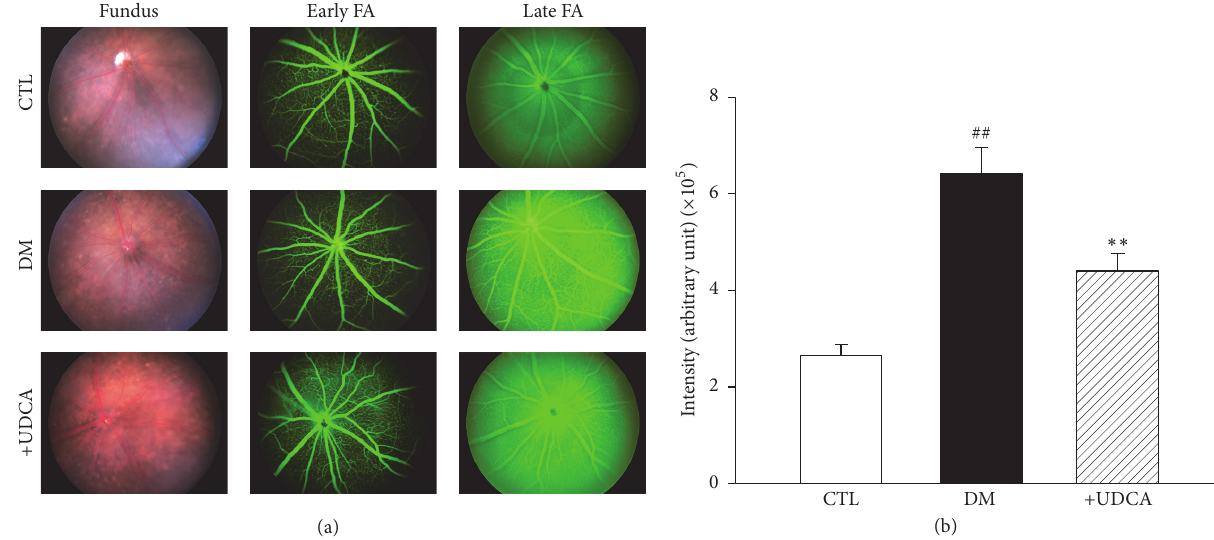
Figure 1: Effect of UDCA on vascular integrity in STZ-induced diabetic mice. (a) Representative fundus images and fluorescein angiography (FA) of early- and late-phase DR in control nontreated and UDCA-treated diabetic mice. (b) Fluorescein leakage was increased in diabetic mice ( 𝑛 = 8 ) at the late phase of fluorescein angiography, compared to control mice ( 𝑛 = 8 ), and decreased in diabetic mice treated with 100mg/kg UDCA ( 𝑛 = 11 ). Fluorescein angiographs of the early phase were obtained 3 min after fluorescein injection (early FA), while those of the late phase (late FA) were taken at 15min. ## 𝑃 < 0.001 versus control mice, ∗∗ 𝑃 < 0.01 versus nontreated diabetic